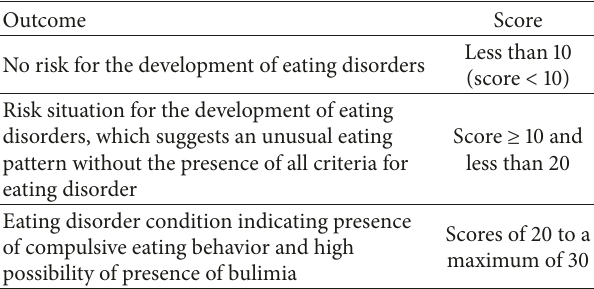
Table 1: BITE’s symptoms